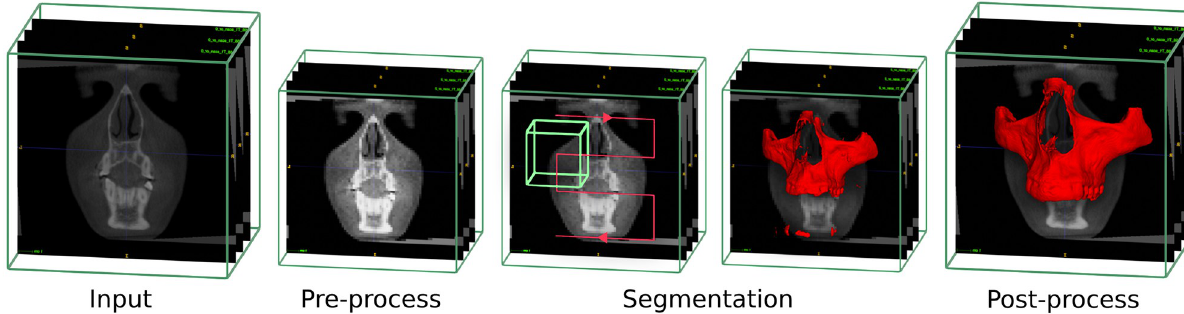
Fig 4. Visualization of the automatic maxilla segmentation steps. Re-sample and contrast adjustment of the input image, segmentation with the sliding window using UNETR, and finally, re-sampling of the cleaned-up segmentation to the input size.